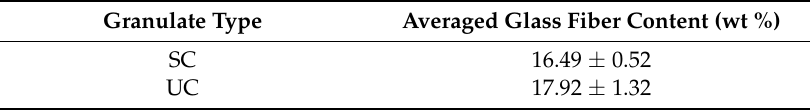
Table 12. Results of the incineration of the matrix material according to DIN EN ISO 1172 and DIN EN ISO 3451.